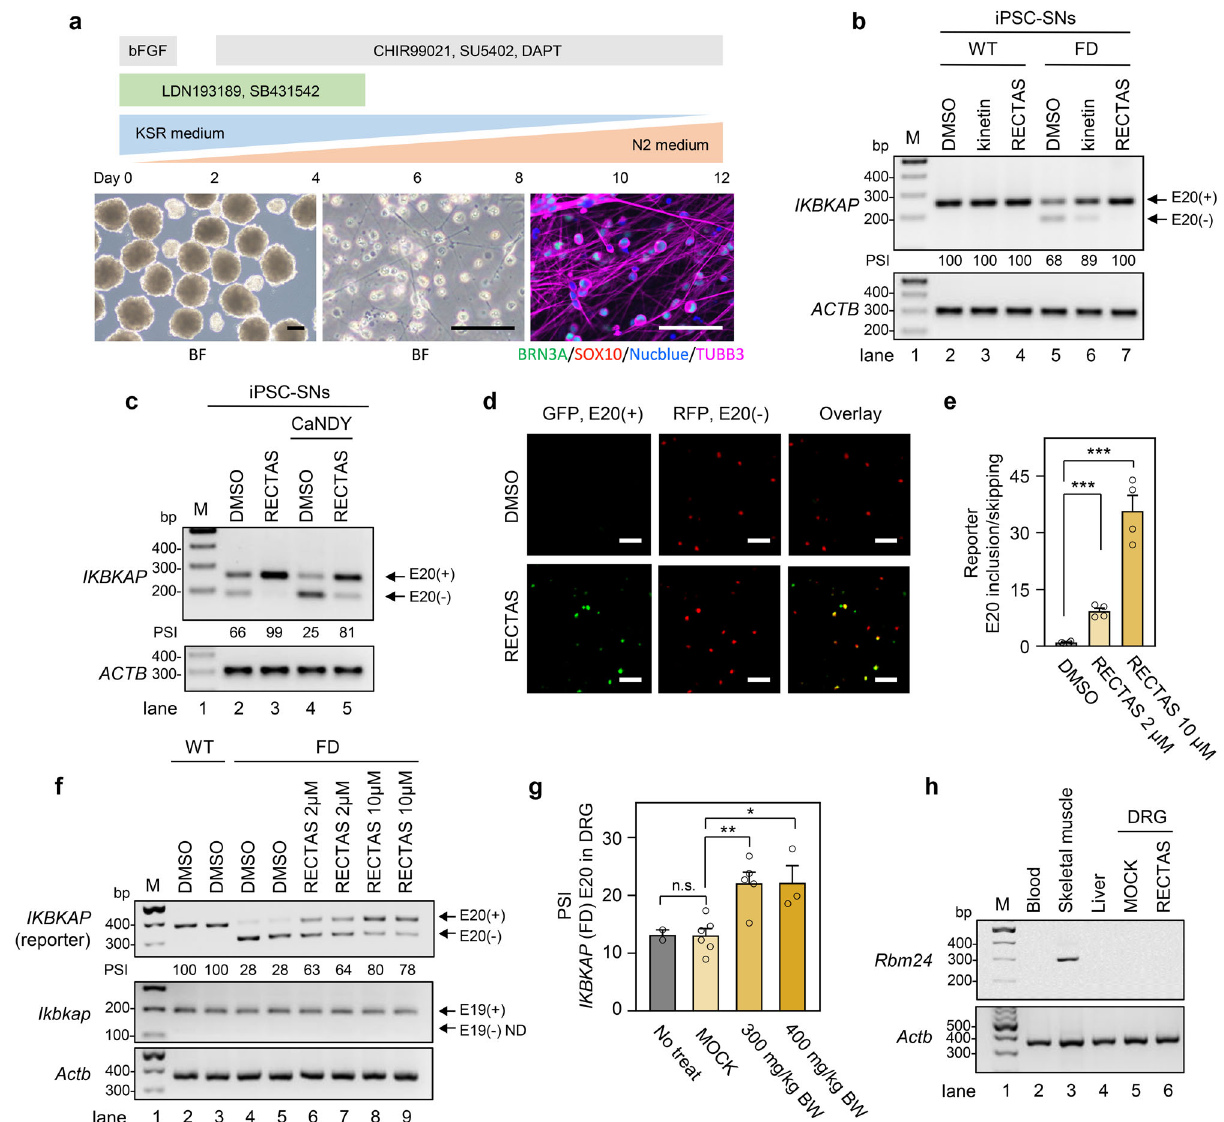
Fig. 4 RECTAS restores IKBKAP -familial dysautonomia (FD) exon 20 inclusion in patient induced pluripotent stem cells-derived sensory neurons (iPSC-SNs) and transgenic mice. a Diagram for preparation of iPSC-SNs, showing time-course (upper), microscopic images of spheroids at day 2 (lower, left), and differentiated iPSC-SNs on day 5 (lower middle for bright fi eld and lower right for BRN3A/SOX10/Nucblue/TUBB3 immunocytostaining image). BF, bright fi eld image; scale bars, 100 µ m. b , c RT-PCR for IKBKAP exon 19 – 21 and ACTB as a loading control for differentiated iPSC-SNs from a healthy donor (WT) or FD patient (FD) on day 12 ( b ), and iPSC-SNs (day 12) treated with CaNDY (10 µ M) or 0.1% DMSO for 2 h, followed by addition of RECTAS (10 µ M) or 0.1% DMSO in media and subsequent incubation for 22 h ( c ). IKBKAP and ACTB were detected with primers oAM138 + oAM139 and oAM13 + oAM14, respectively. d , e Microscopic images ( d ) and quanti fi cation for the extent of IKBKAP- FD exon 20 inclusion ( e ), following treatment with RECTAS (10 µ M for ( d ), and 2 and 10 µ M for ( e )) or solvent only (0.1% DMSO) for 24 h in neuro 2A cells transfected with the IKBKAP- FD reporter. Bars, 100 µ m in ( d ). f RT-PCR for exogenous human IKBKAP (oAM124 + oAM126, primers designed for vector backbone) and endogenous mouse Ikbkap (oAM666 + oAM667, primers designed for exon 18 and 20) in neuro 2A cells transfected with IKBKAP -WT or -FD reporter and treated with 2 or 10 µ M RECTAS or 0.1% DMSO for 24 h. Actb (oAM364 + oAM366) served as a loading control. g Quanti fi cation of PSI for IKBKAP -FD exon 20 in DRG from IKBKAP- FD- humanized transgenic mice administered RECTAS (300, or 400 mg/kg BW, p.o.) with a booster administration of the same dose at 4 h, and DRG were collected 8 h after the fi rst administration to be applied for RT-PCR for IKBKAP exon 19 – 21 with primer set of HsIKAPRT18F + HsIKAPRT21R ( n = 2 for no treatment, n = 6 for MOCK, n = 5 for 300 mg/kg BW RECTAS, and n = 3 for 400 mg/kg BW RECTAS). MOCK, control for the vehicle only. h RT-PCR for Rbm24 in blood cells, skeletal muscle, and liver tissues from 2-month-old B6 mouse, as well as DRG from MOCK or RECTAS (300 mg/kg BW)- administered IKBKAP -FD transgenic mice. Actb served as a loading control. Rbm24 and Actb were detected by primers Rbm24-F + Rbm24-R and oAM365 + oAM366, respectively. Data from three iPSC clones are shown in ( a – c ), four replicates were shown in ( d – e ), two replicates are shown in ( f ). Representative data from two experiments are shown in ( h ). E20 ( + ), exon 20 inclusion product; E20 ( − ), exon 20 skipping product; E19 ( + ), exon 19 inclusion product; E19 ( − ), exon 19 skipping product in ( b ), ( c ), and ( f ). Columns, mean; bars, SE; n.s., P ≥ 0.05; ** P < 0.01; *** P < 0.001 for unpaired two- tailed t test in ( e ) (vs. DMSO control: 2 µ M, P = 5.6 × 10 − 5 ; 10 µ M, P = 1.5 × 10 − 4 ) and ( g ) (vs. MOCK control: no treat, P = 0.97; 300 mg/kg BW, 2.4 × 10 − 3 ; 400 mg/kg BW, 1.0 × 10 − 2 ); PSI, percent spliced-in in ( b ), ( c ), and ( f ); ND, not detectable in ( f